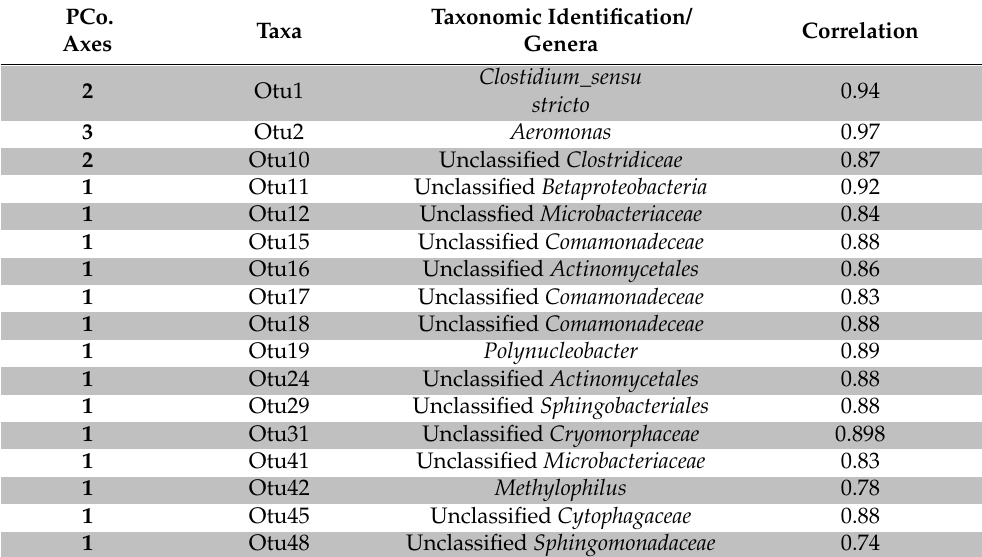
Table 3. List of microbial taxa with established taxonomic identification that were shown to be highly correlated with eigenvectors of the first three principal coordinate axes associated with largest eigenvalues. Taxonomic Identification/ PCo. Correlation Taxa Genera Axes Clostidium_sensu Otu1 stricto